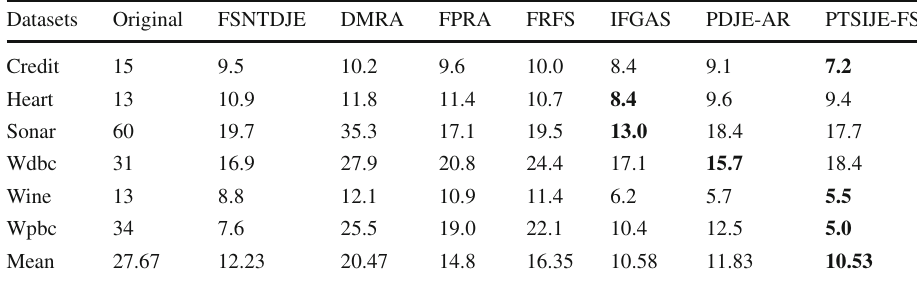
Table 3 The number of selected features with the seven methods on the six UCI datasets